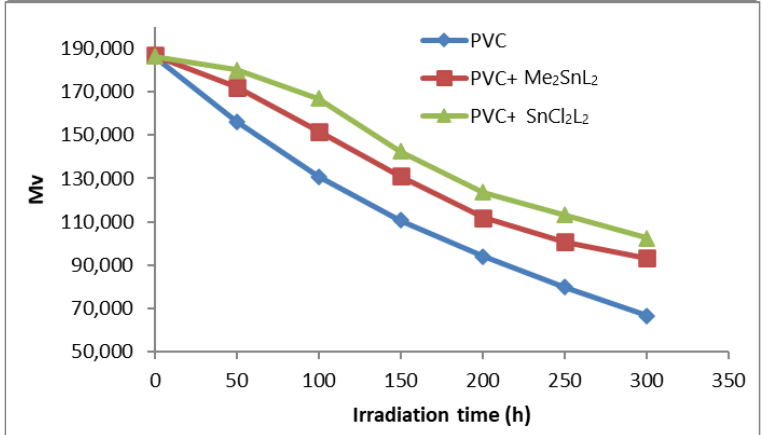
Figure 7. Changes in M V for PVC films versus irradiation time.